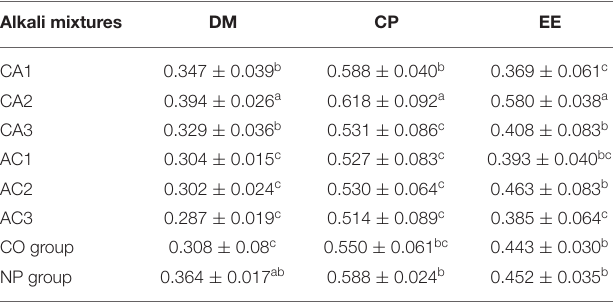
TABLE 6 | Effects of processed WCS on serum biochemical parameters and free gossypol content. Items